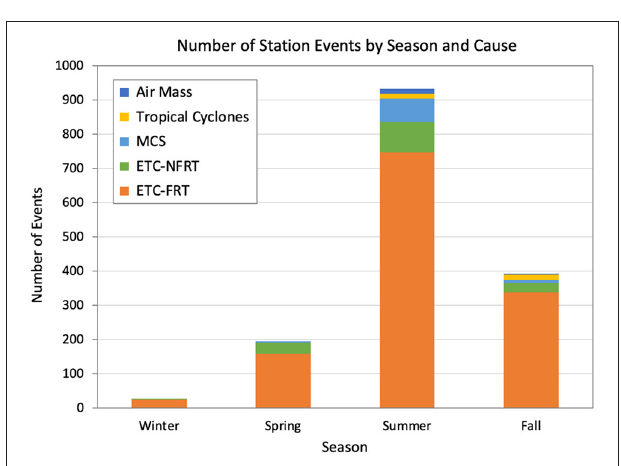
FIGURE 10 | Seasonal distribution of the number of extreme station events categorized by meteorological